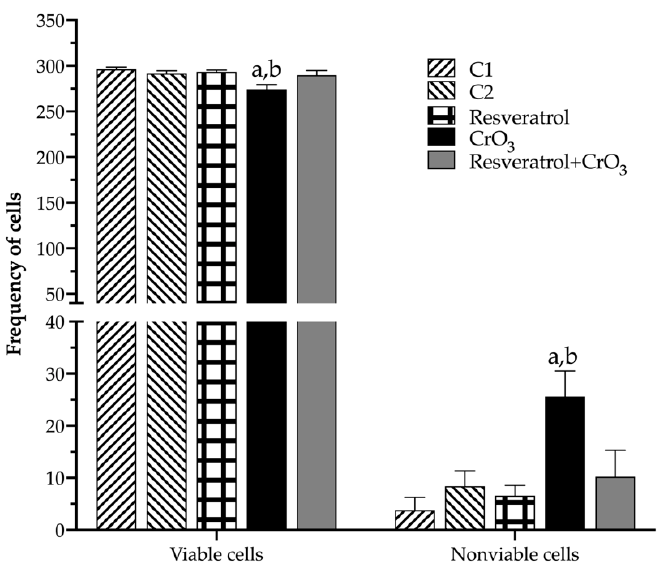
Figure 6. Effect of resveratrol and CrO 3 on the frequencies of viable and nonviable cells in the pe- ripheral blood of mice evaluated 48 h after treatment using differential acridine orange/ethidium bromide (AO/EB) staining. Viable cells include healthy and early apoptotic cells. Nonviable cells include late apoptotic and necrotic cells. A total of 300 nucleated cells were evaluated for each